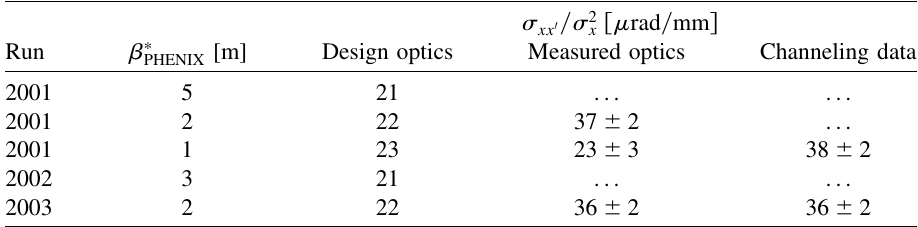
=(cid:6) 2 to model. xx 0 x